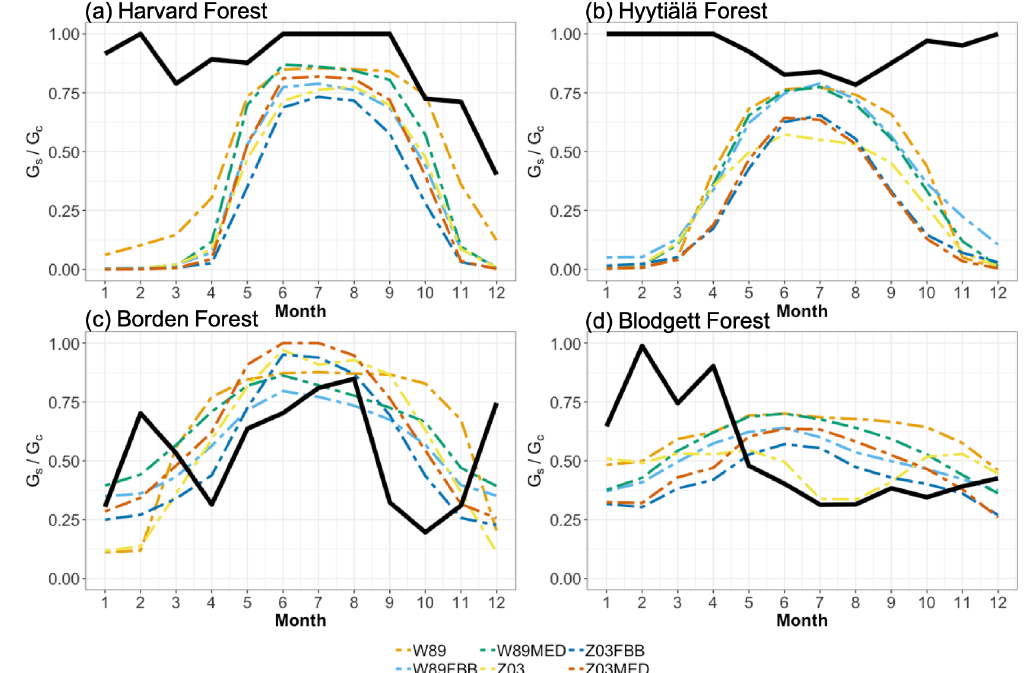
Figure 5. Fractions of average monthly daytime stomatal conductance ( G s ) to canopy conductance ( G c = 1 /R c ) at the four long-term measurement sites. Black lines indicate fractions calculated with G s derived using the P-M method. Colored solid lines indicate fractions calculated with different dry deposition